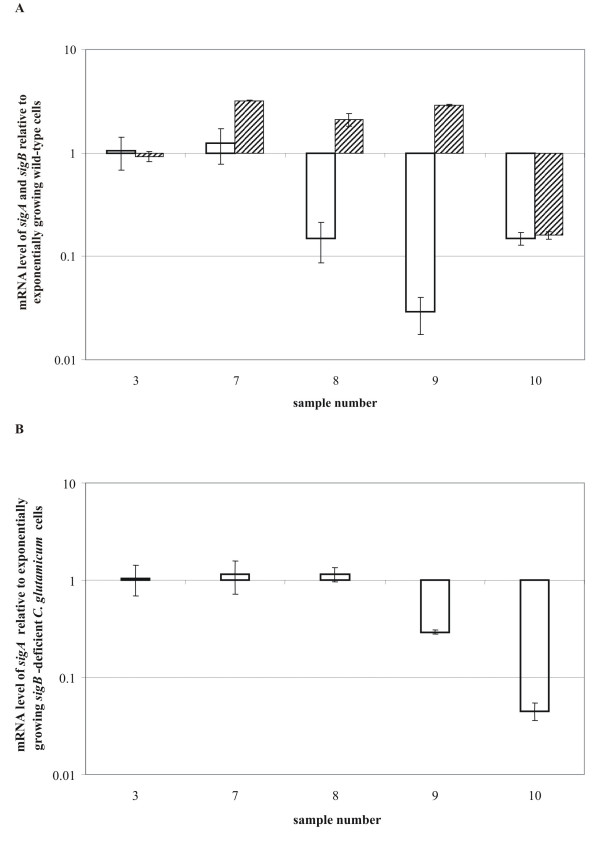
Relative levels of sigA and sigB mRNA in C. glutamicum RES167 at different phases of growth. (A) The bars show mRNA levels of sigA (solid bars) and sigB (speckled bars) calculated in relation to those determined at early exponential growth phase in the wild-type. The sample numbers correspond to the sampling points marked in Figure 1. (B) The bars show mRNA levels of the sigA gene in the sigB-deficient C. glutamicum strain CL1.